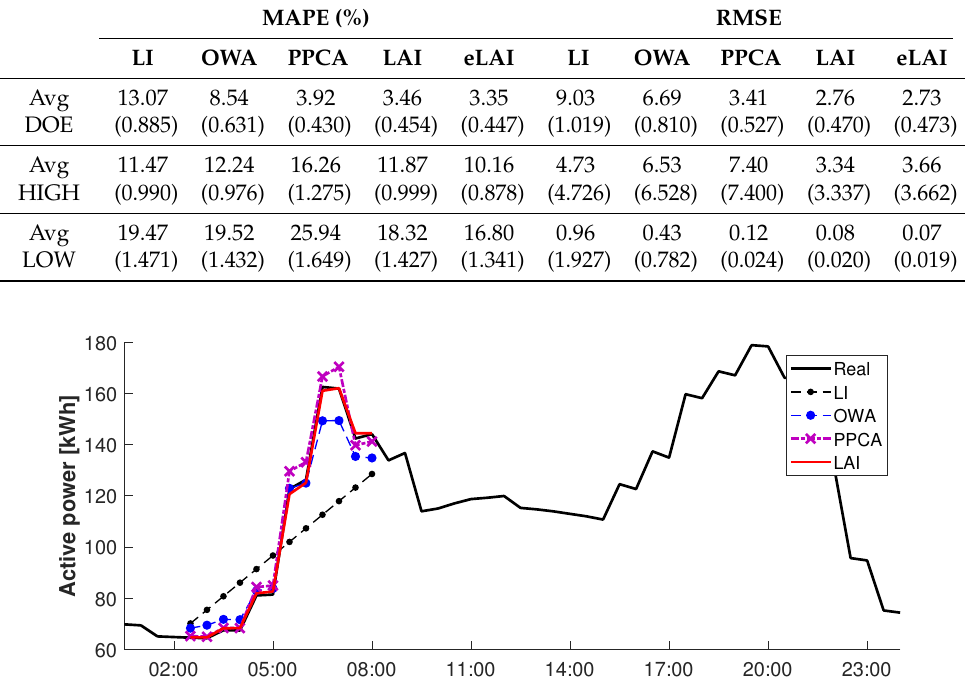
Figure 10. Example of missing power data imputation.